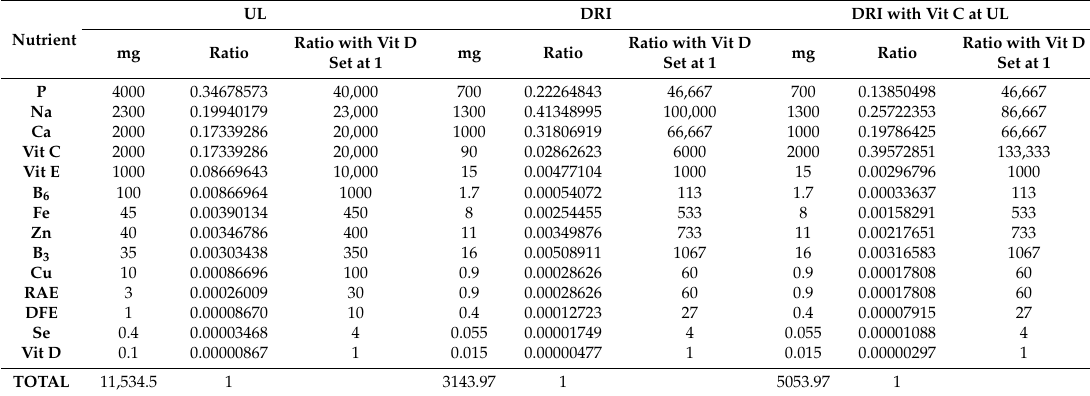
Table 6. Tolerable Upper Intake Levels (ULs) and Dietary Reference Intakes (DRIs) for males 51–70 years, their ratios and ratios relative to vitamin D and a hypothetical diet containing the DRI levels but with vitamin C at the UL and both ratios.